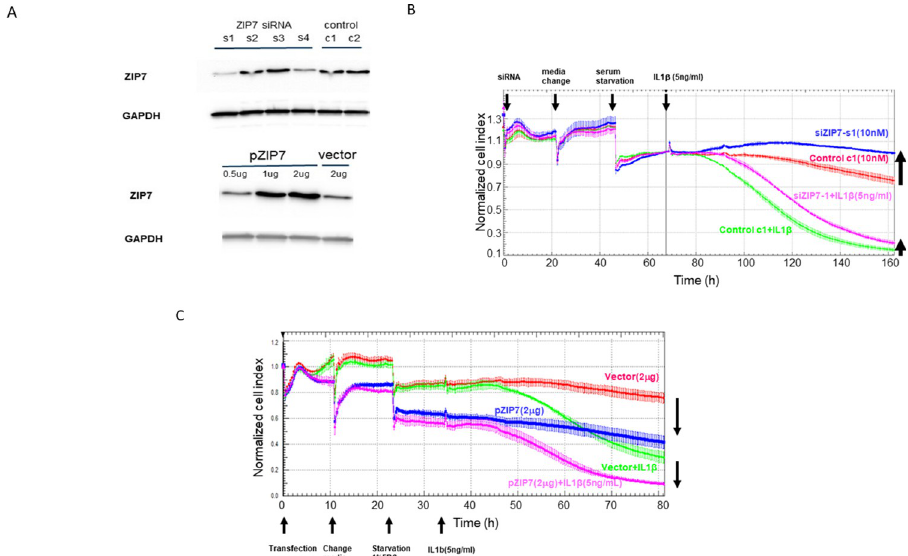
Fig 2. Validation of the role of Zip7 in mediating barrier dysfunction by Zip7 knockdown or overexpression. A: Cells were transfected with various siRNA oligos and after 72h lysates were made and western blot analysis performed as described in the methods section. siRNA oligo siRNA-1 and siRNA-4 both reduced levels of endogenous Zip7 whereas the expression construct caused increased levels of Zip7 protein in the cell lysates. B: Confluent ARPE-19 cells were treated with10 nM of Zip7 siRNA (s1) or control siRNA (c1) in the presence of 5 ng/mL IL-1 β . Zip7 knockdown increased impedance vs cells transfected with control siRNA. Treatment of cells with IL-1 β reduced impedance and Zip7 knockdown reduced the impedance loss indicating Zip7 contributes to barrier loss induced by IL-1 β . C: Confluent ARPE-19 cells were transfected with a Zip7 expression construct or a vector control and after 48h treated with media or 5 ng/mL of IL-1 β . Zip7 overexpression reduced impedance in resting cells and overexpression of Zip7 reduced impedance during challenge with IL-1 β more than the reduction observed after cells transfected with control vector were challenged with IL-1 β